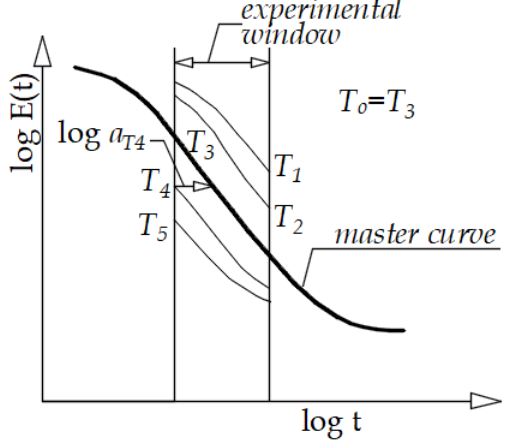
Figure 1. Schematic representation of a relaxation module for a polymer [24].